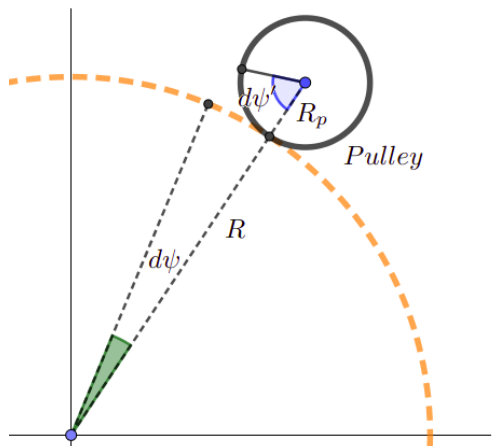
Figure 24. The relation between the pulley rotation and ψ